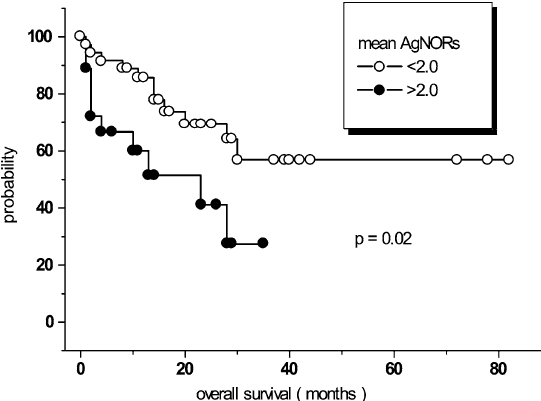
Fig. 4. Overall survival curve of the patients with B large cell NHL according to the presence of a DNA-aneuploid clone. pheric lymphoma and patients with large cell lym-